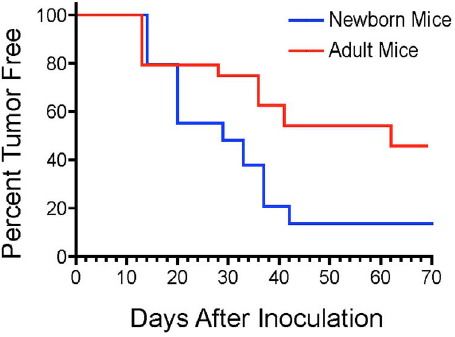
Figure 2. Kinetics of tumor appearance. Adult (4 weeks) and newborn (1 to 2-day old) mice were inoculated SC with 25 m g pMSV- T24-H- ras /MSV-c- myc DNA and followed for tumor appearance. Tumors were visible when they reached approximately 5 mm in diameter and were scored at that time. Observation was for a total of 6 months. Data were plotted according to the Kaplan-Meier estimator using GraphPad Prizm 5 software. The p value for the statistical equivalence of the two curves was